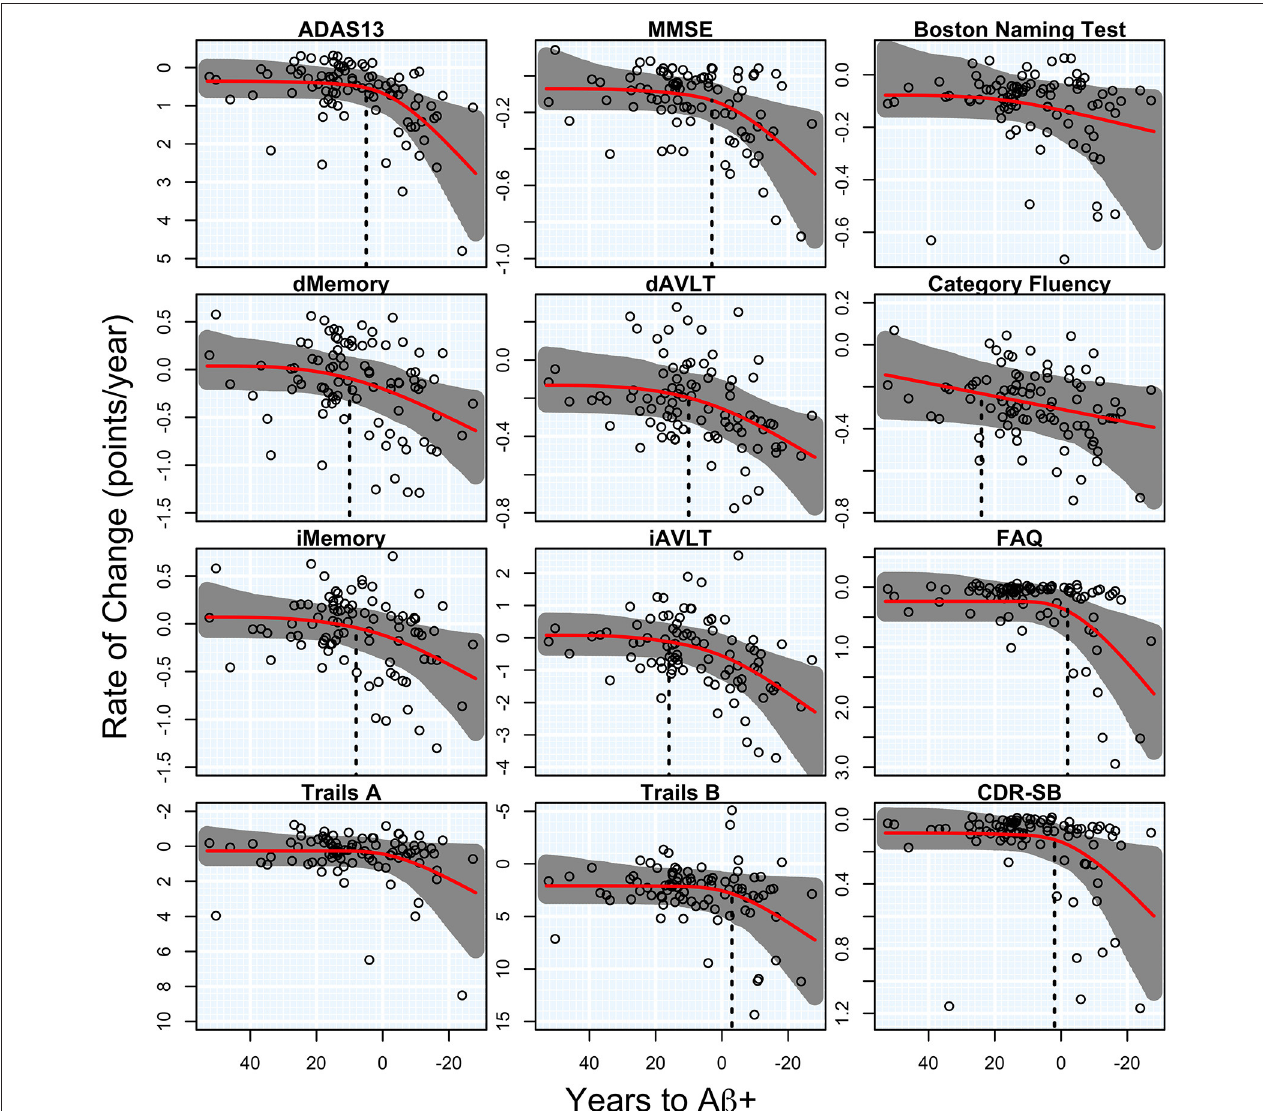
FIGURE 4 | Cognitive and functional rates of change. Annual rates of change for cognitive and functional measures are plotted against time to A β -positivity. Rates of cognition or function worsen from top to bottom and time to A β -positivity decreases from left to right. Estimated curves are in red with 95% confidence intervals shaded in gray. The vertical dashed line in black is the estimate of the initial acceleration point, if it